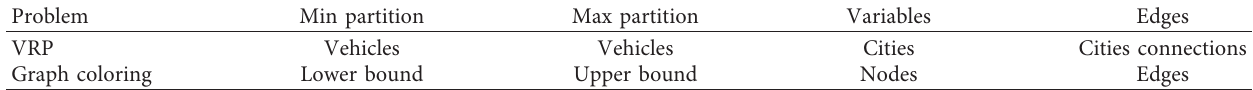
Table 3: Basic features for CVRP and graph coloring.